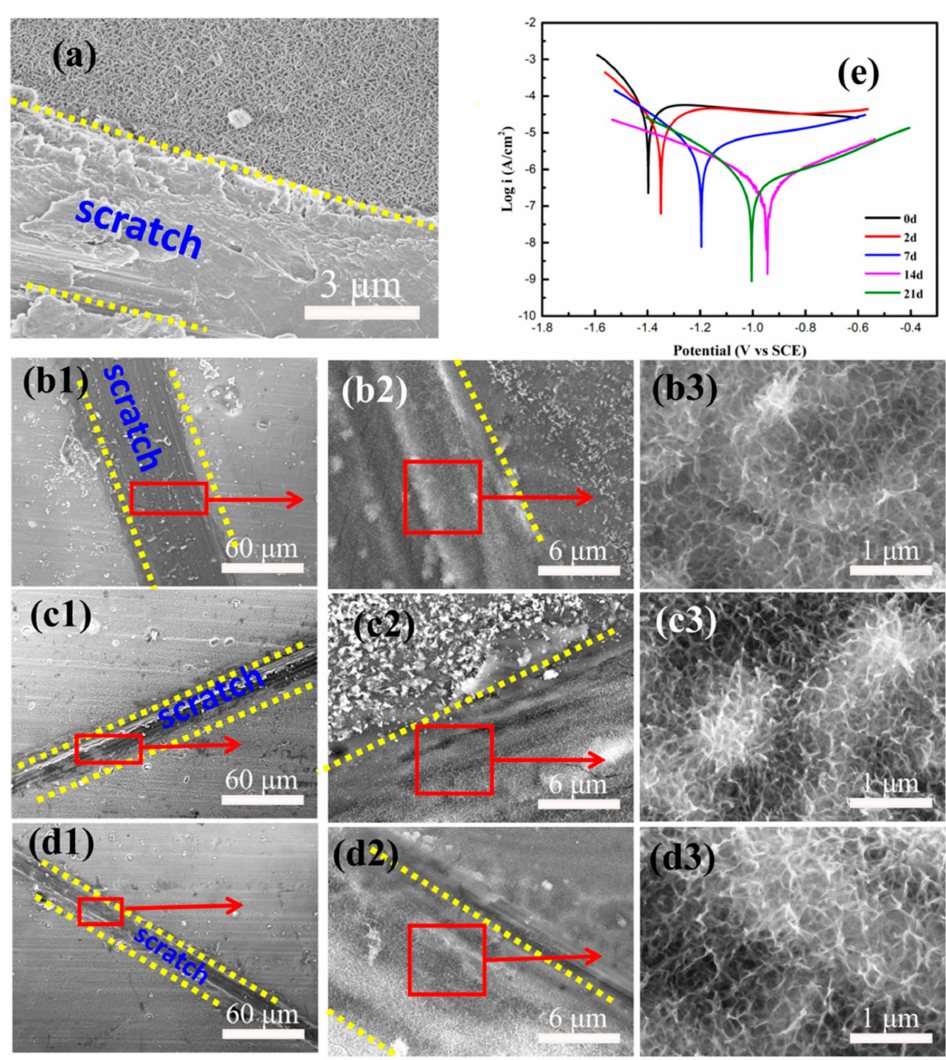
Figure 6. SEM of MLDHs on Al alloy with artificial scratch ( a ) and after immersion in 3.5 wt.% NaCl solution for 8 d ( b1 – b3 ), 15 d ( c1 – c3 ), 21 d ( d1 – d3 ), and polarization curves of the MLDHs with artificial scratched for different immersion times ( e